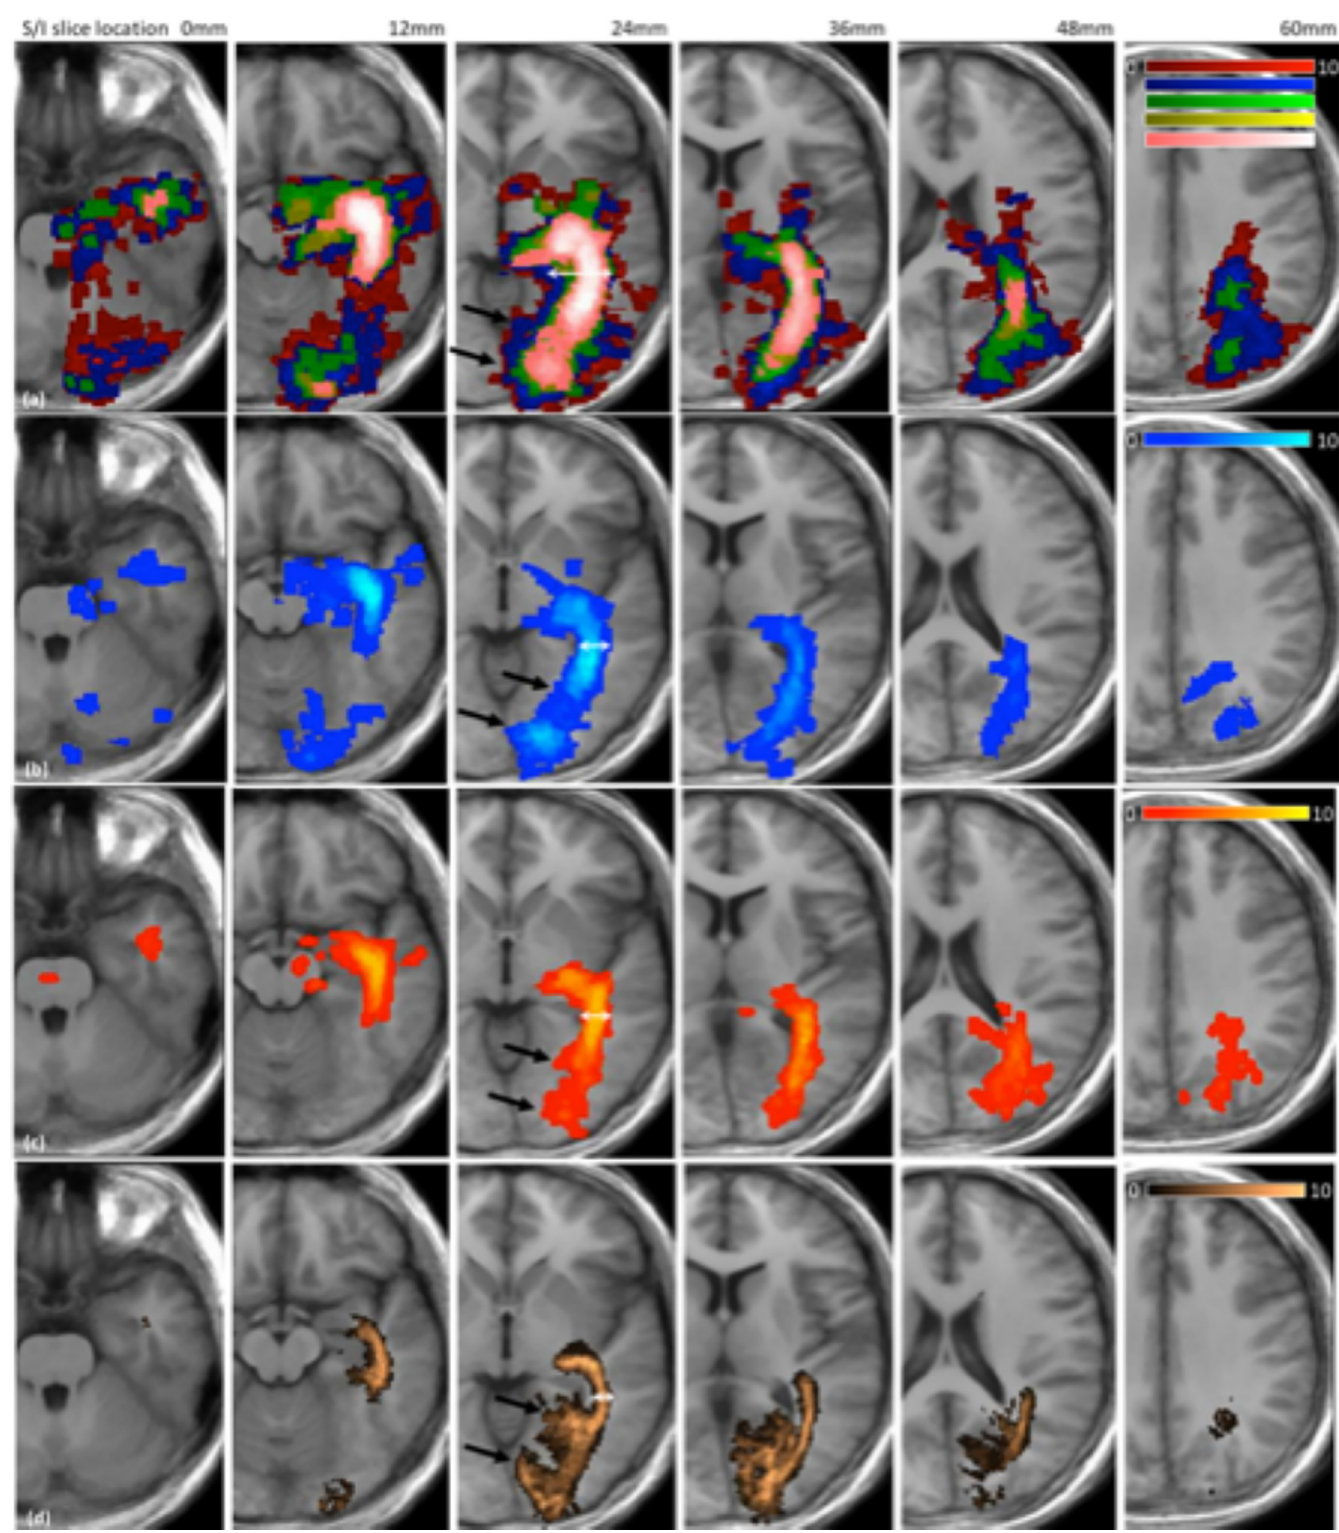
Fig 5. Tract frequency maps for the OR in standard space overlaid on the average structural image for all 10 volunteer subjects. Each column represents a different axial slice location. Row (a) Prob 0.005 (red), Prob 0.001 (blue), Prob 0.025 (green), Prob 0.05 (yellow), Prob 0.075 (pink), Row (b) CSD-stream, Row (c) STEALTH, Row (d) Ju¨lich